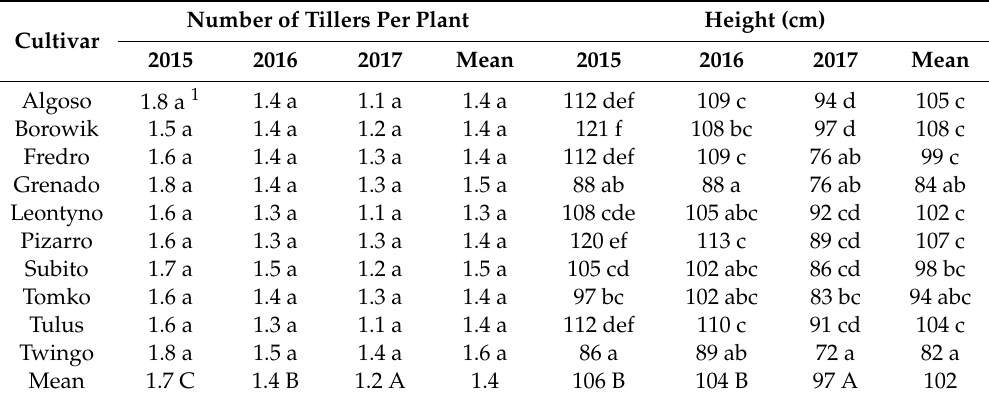
Table 4. Tillering coe ffi cient and height of triticale cultivars grown in the organic system at the dough